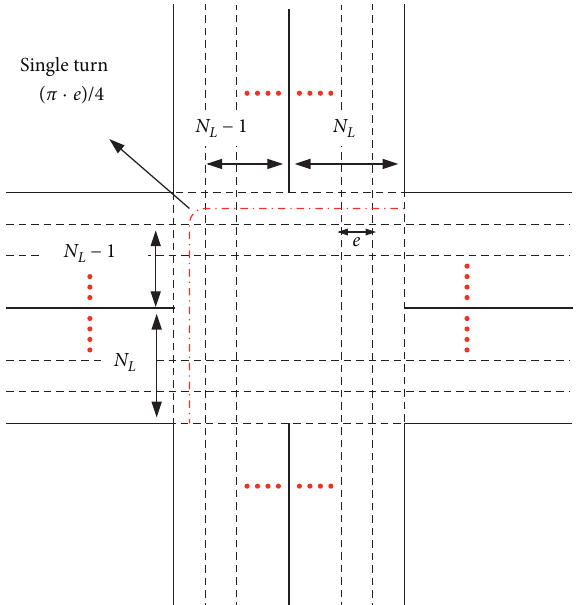
Figure 5: The longest possible path that a vehicle can travel in the IR. It is traveled by the vehicles that transport at the outermost right lane of the CR and make a left turn at the IR.